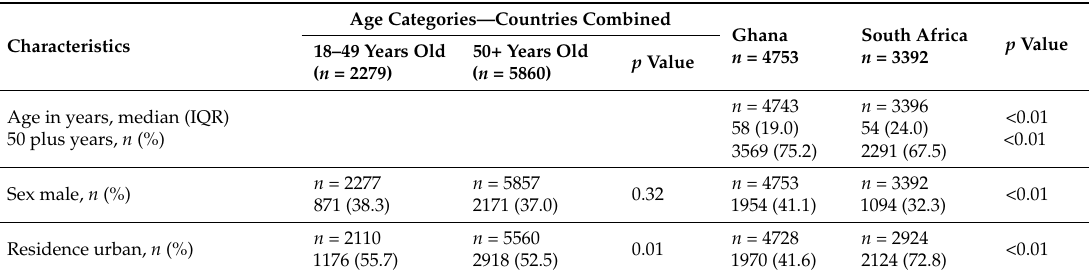
Table 1. Sociodemographic characteristics and selected health characteristics of the study samples in Ghana and South Africa, Study on Global Ageing and Adult Health (SAGE) Wave